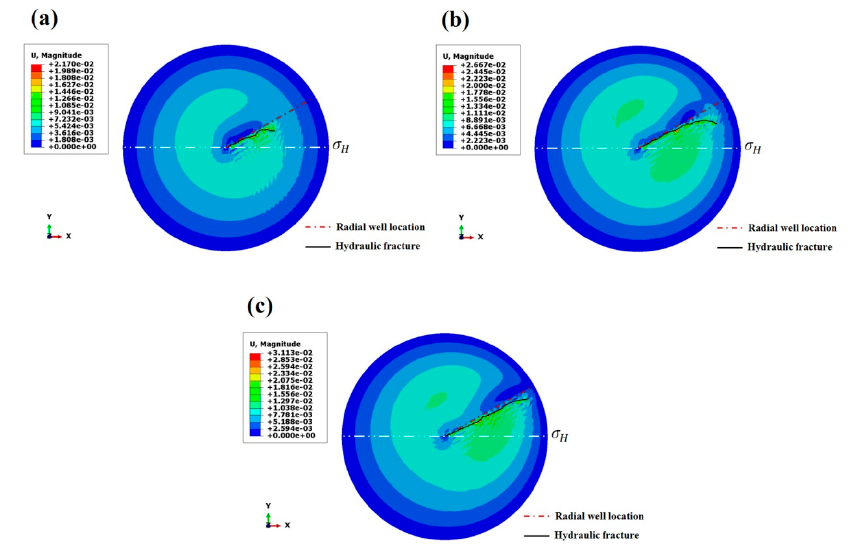
Figure 10. When the Young’s modulus is 13 Gpa, the hydraulic fracture deflects after extending for 17.50 m along the radial borehole orientation, and its guidance factor is 0.015, which has the strongest guidance strength among three Young’s modulus. Energies 2017 , 10 , 1680